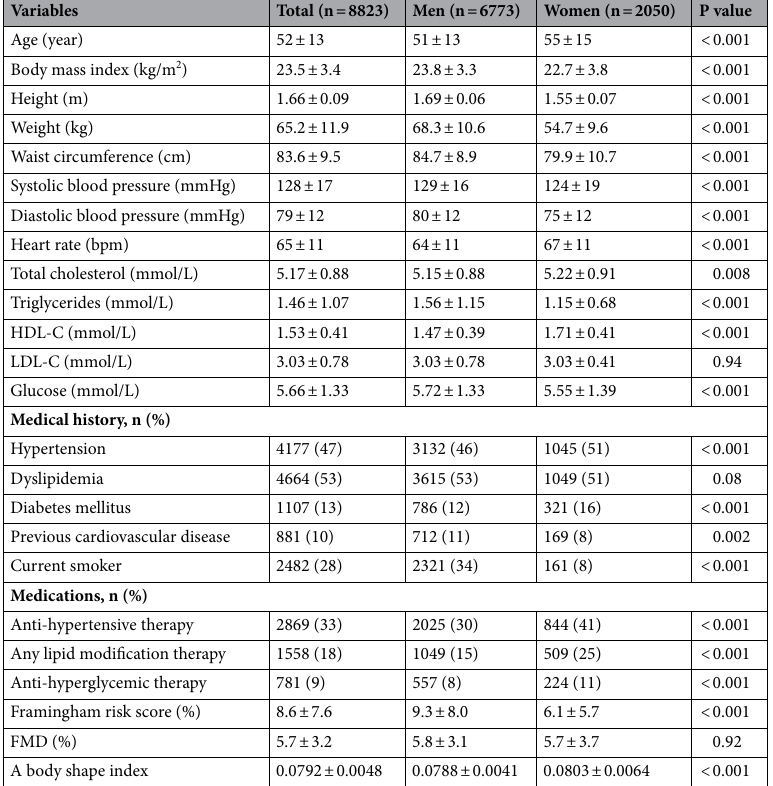
Table 1. Clinical characteristics of the subjects. Results are presented as mean ± SD for continuous variables and percentages for categorical variables. HDL-C high-density lipoprotein cholesterol, LDL-C low-density lipoprotein cholesterol, FMD flow-mediated